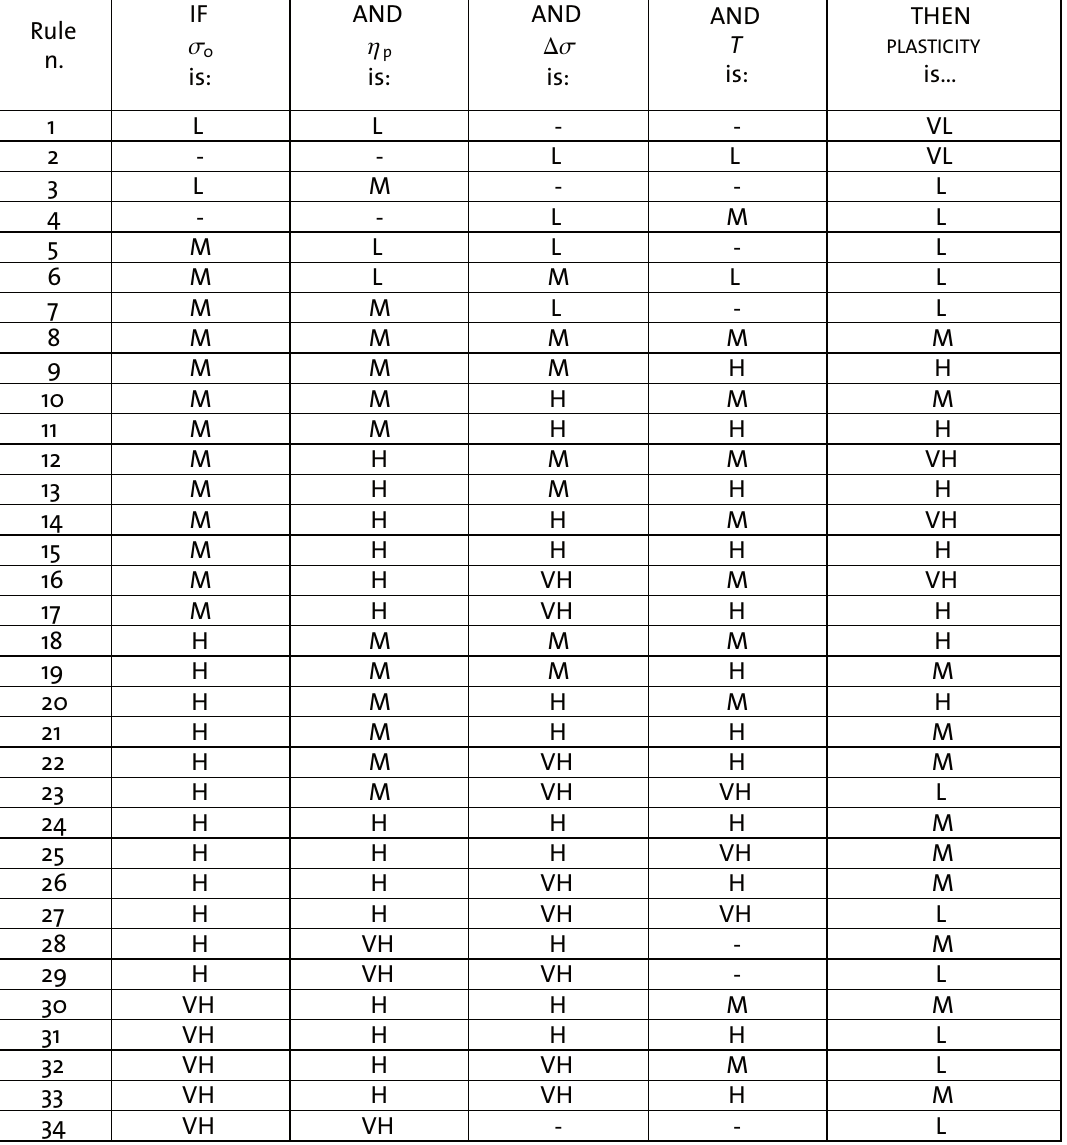
Table 1: Rules of the knowledge base for estimating plasticity (VL very low, L low, M medi- um, H high, VH very high). (see Figs. 5 –